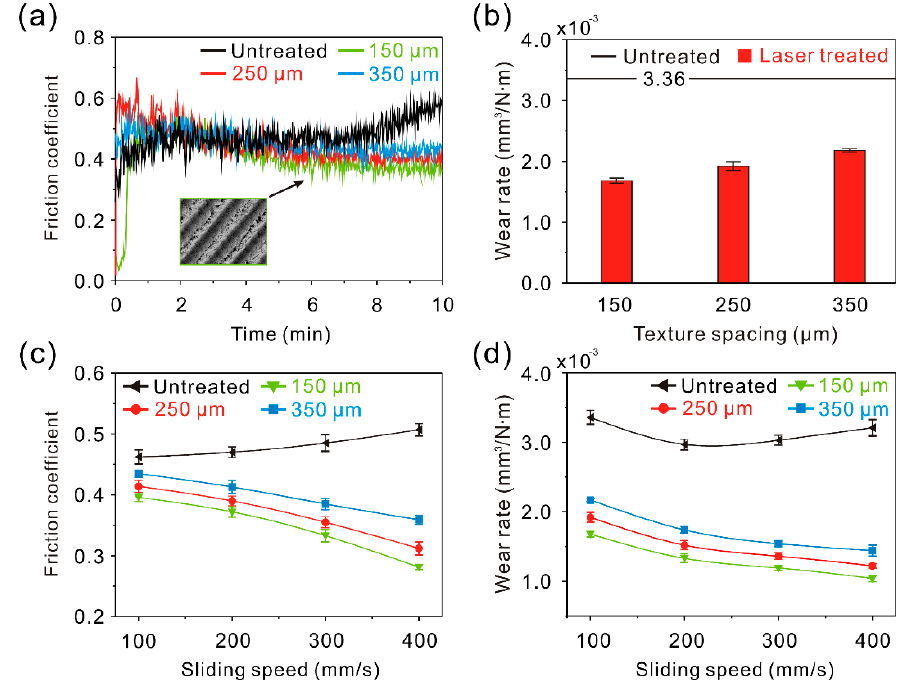
Figure 6. ( a ) Curve of dynamic friction coefficient of the LGS; ( b ) wear rate of the LGS; ( c ) variation of the friction coefficient of the LGS with sliding speed; ( d ) variation of the wear rate of the LGS with sliding speed (load of 0.3 N, sliding speed of 100 mm/s, frictional pair of GCr15 bearing steel, friction time of 10 min).